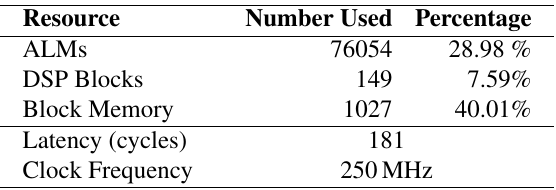
Figure 1. Illustration of the processing carried out by the DFE and host CPU and the movement of data between them. Table 2. Resource usage and timing metrics of the Kalman Filter state updater, and peripheral communications, on a Maia DFE. Resources are also expressed as a percentage of the Altera Stratix V 5SGSD8 device